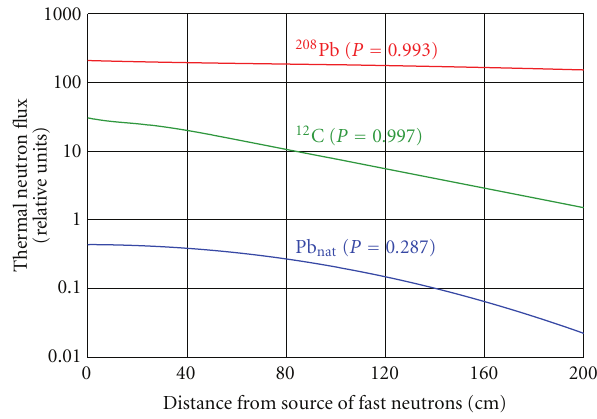
Figure 9: Thermal neutron flux in 208 Pb, graphite, and natural lead depending on distance from the